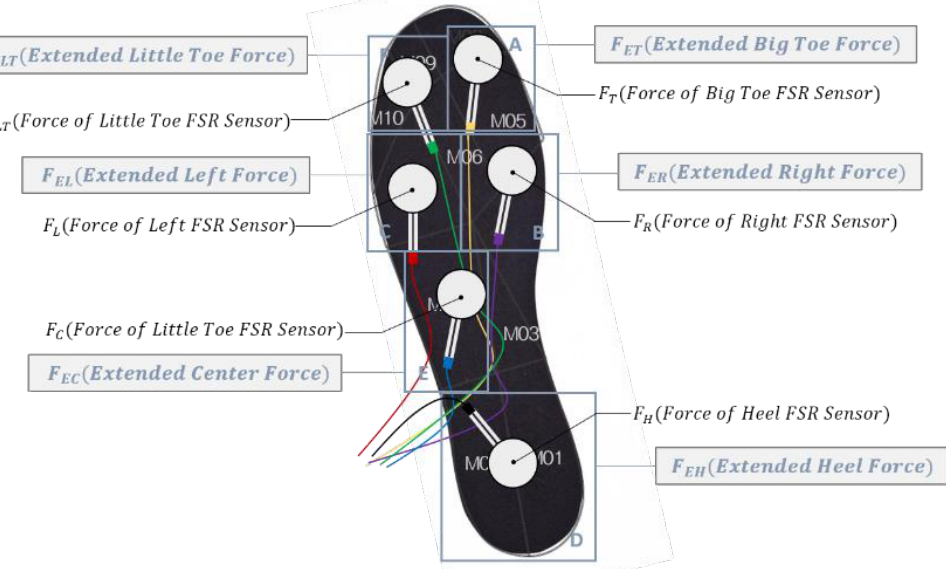
Figure 1. Design of the low-cost flexible insole pressure measurement sensor with six FSR sensors. Gray circles with wires show the FSR sensors. White bolded numbers indicate the anatomically divided areas. Blue squares mean the areas of the virtual forces that contain the FSR sensors in them.